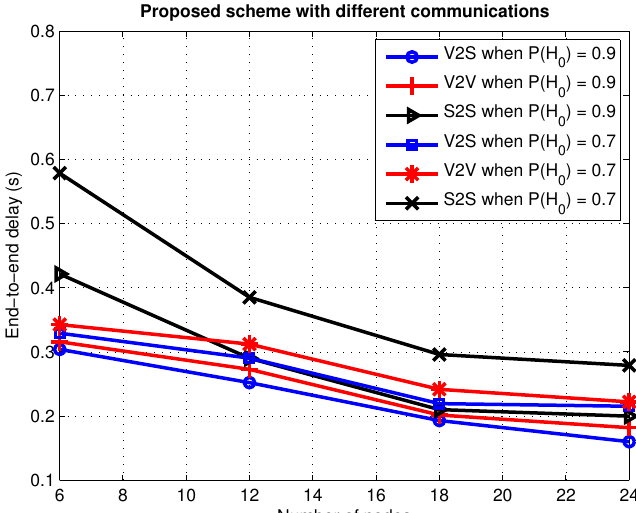
Figure 5. Performance comparison between the proposed hybrid and pure communications in terms of end-to-end